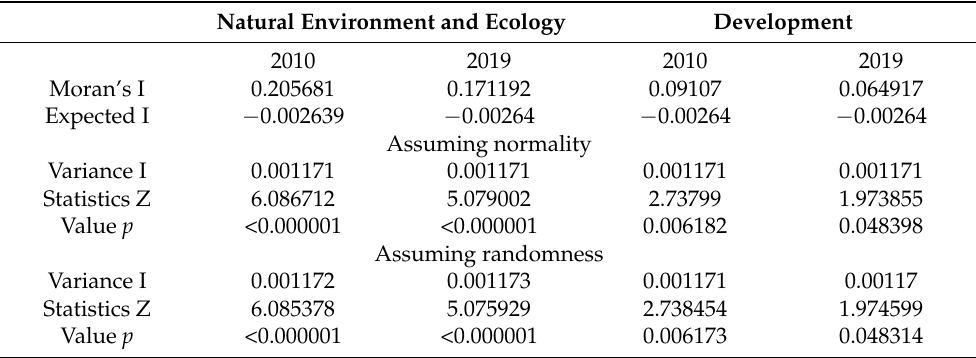
Table 7. Values of global Moran’s I statistics for the synthetic measure of development as well as the natural environment and ecology in terms of counties in